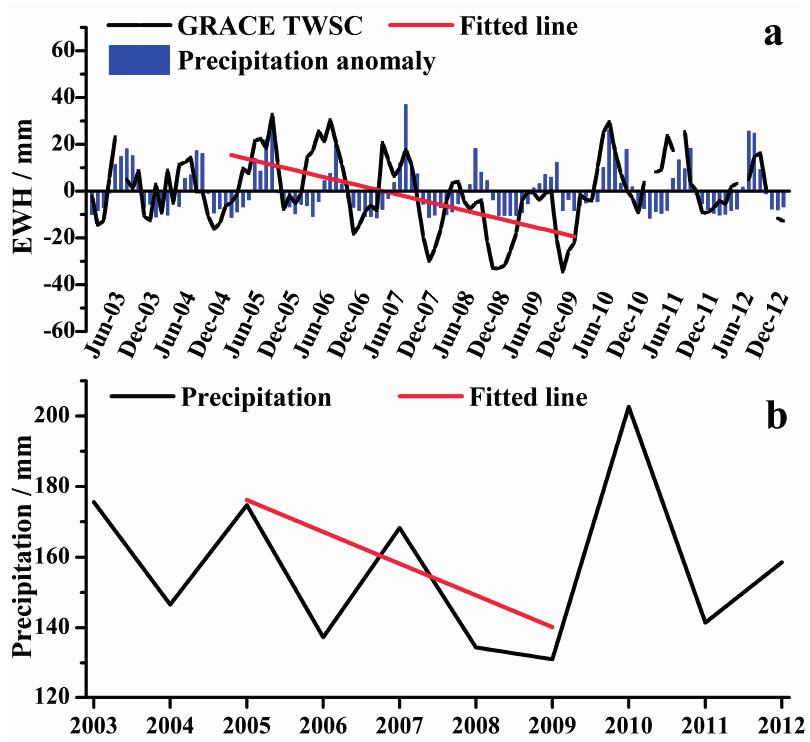
Figure 5. GRACE-derived TWSC and precipitation: (a ) GRACE-derived TWSC and precipitation anomalies; ( b ) yearly annual